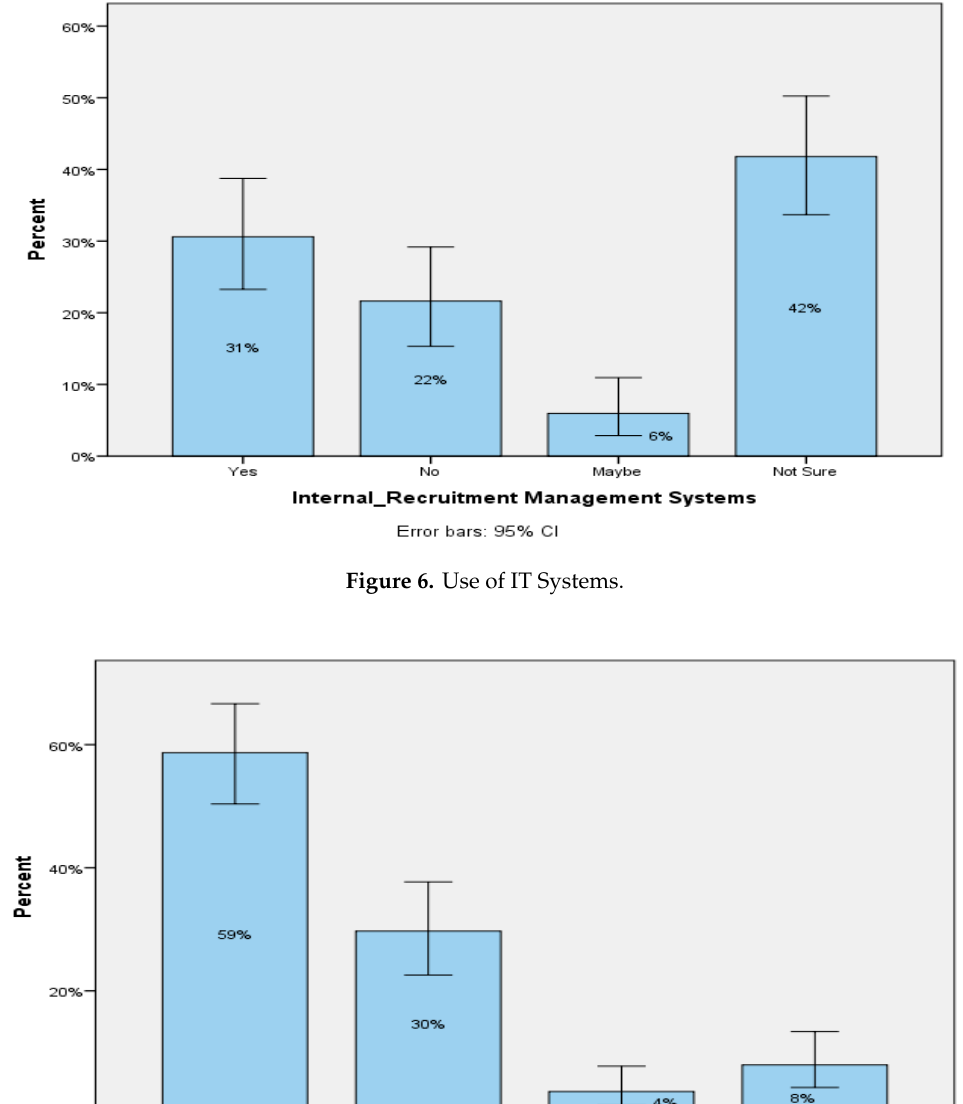
Figure 5. Interview Training by organisation.